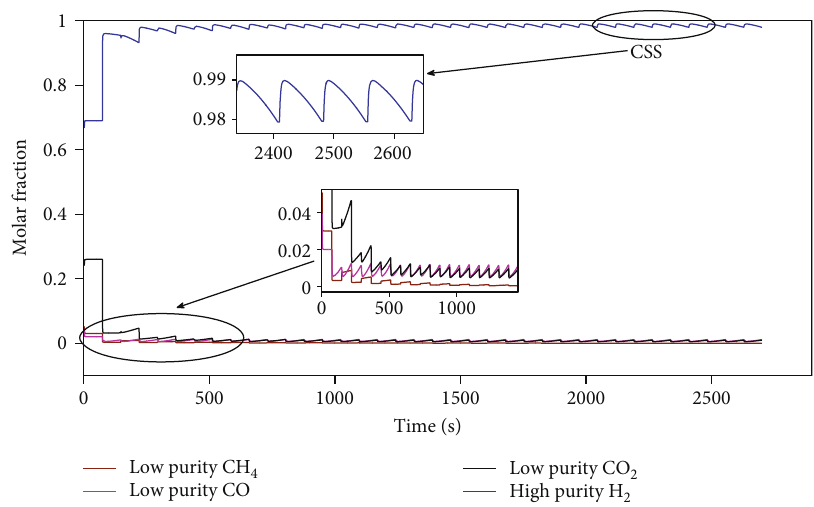
Figure 7: Puri fi cation and production of biohydrogen from the start-up. Table 10: Distributed parameter models of the PSA processes for biohydrogen production. Reference Equations governing the PSA process (nonlinear model) Temperature e ff